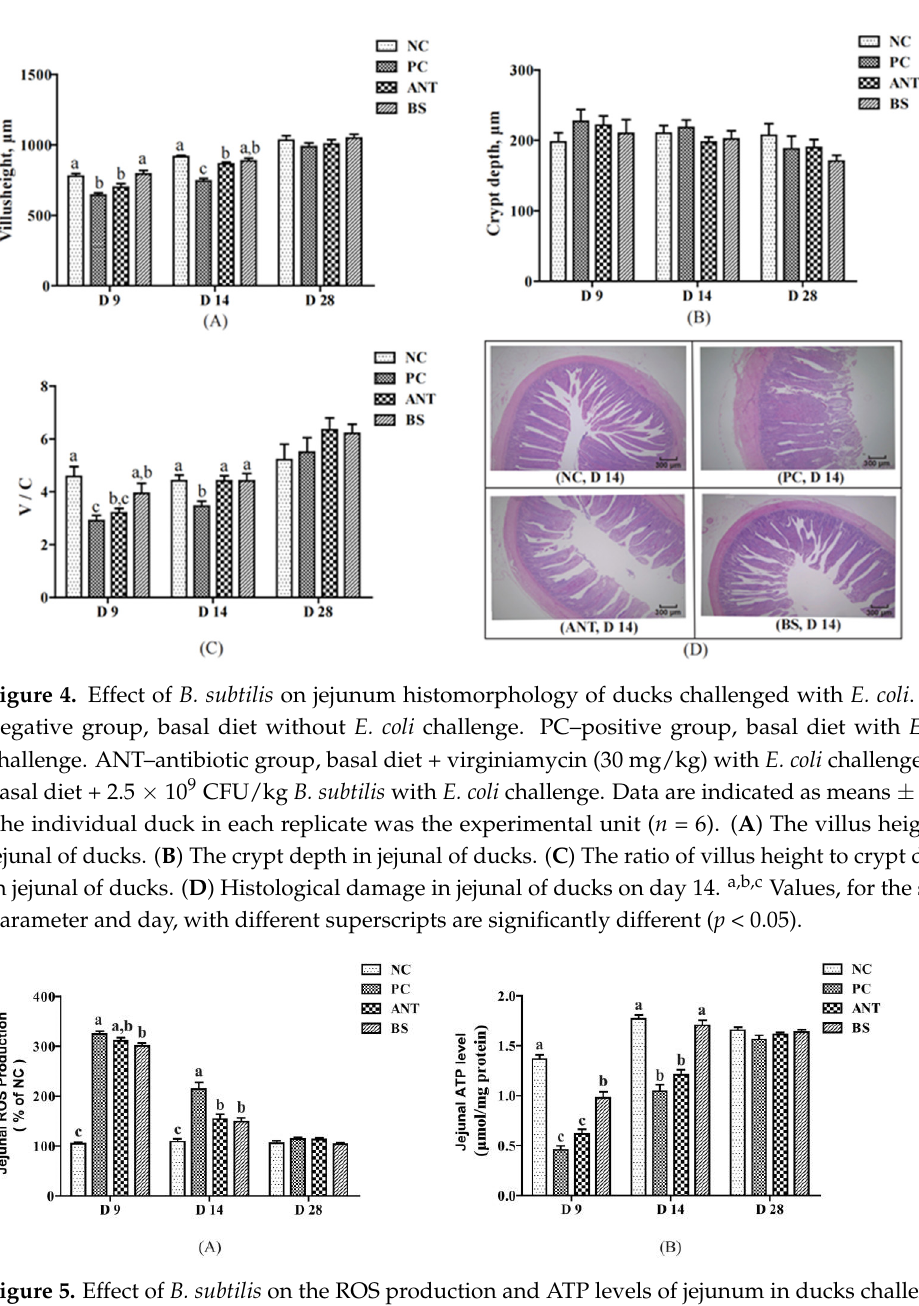
Figure 5. Effect of B. subtilis on the ROS production and ATP levels of jejunum in ducks challenged with E. coli . NC–negative group, basal diet without E. coli challenge. PC–positive group, basal diet with E. coli challenge. ANT–antibiotic group, basal diet + virginiamycin (30 mg/kg) with E. coli challenge. BS–basal diet + 2.5 × 10 9 CFU/kg B. subtilis with E. coli challenge. Data are indicated as means ± SEM. The individual duck in each replicate was the experimental unit ( n = 6). ( A ) ROS, reactive oxygen species. ( B ) ATP, adenosine triphosphate. a,b,c Values, for the same parameter and day, with different superscripts are significantly different ( p <